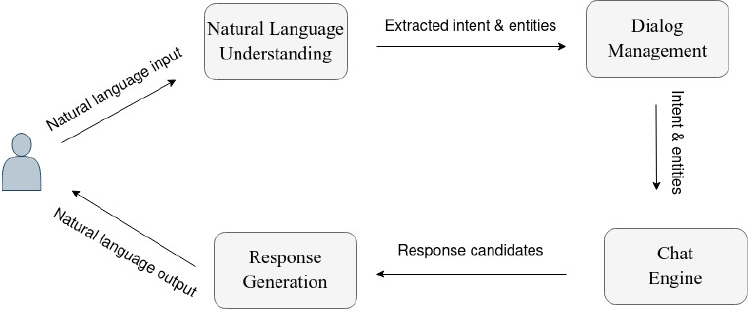
Figure 7. Chatbot process